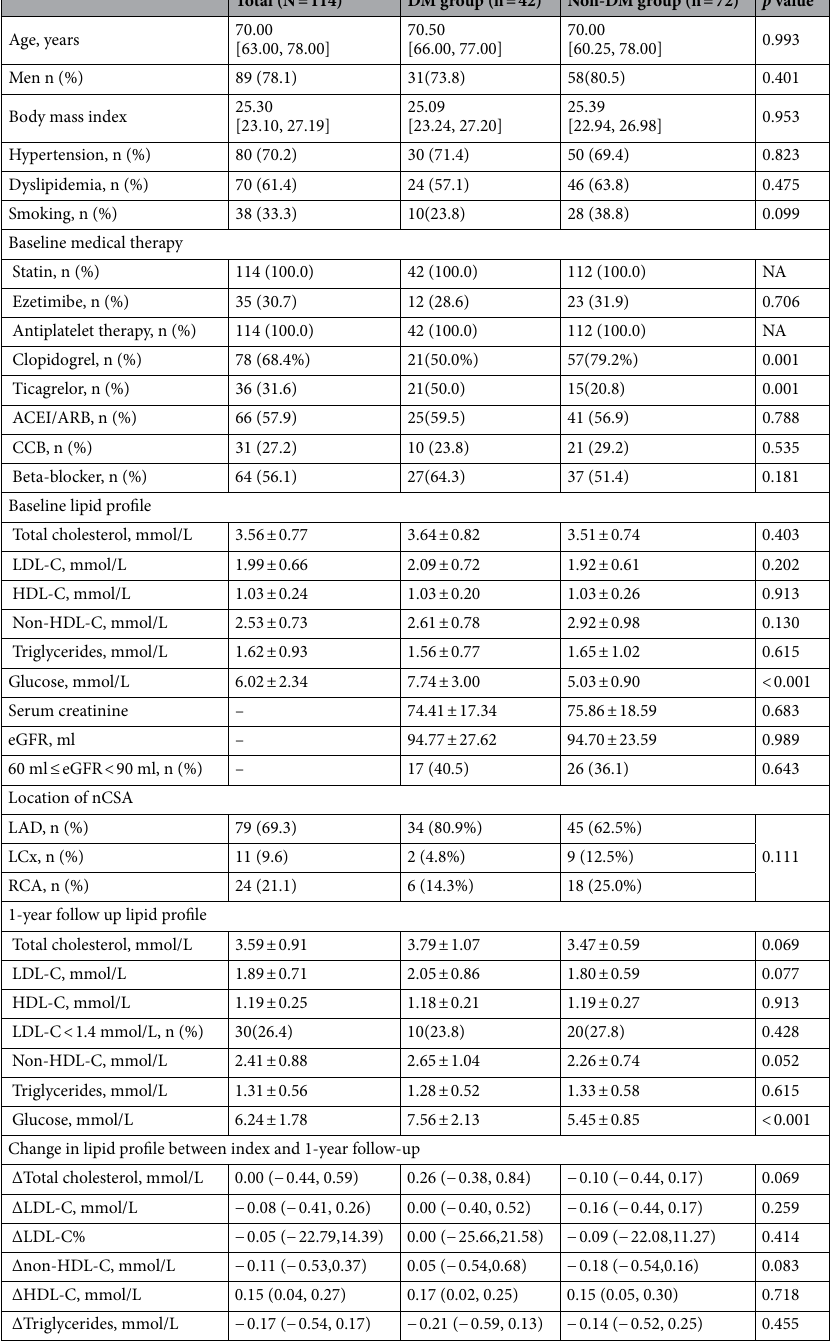
Table 2. Patient demographics in phase II analysis. Values are expressed as the median (interquartile range) for continuous variables with abnormal distribution and described as the mean ± standard deviation with normal distribution, or frequency (percentage) for categorical variables in the table. ACEI angiotensin- converting enzyme inhibitor, ARB angiotensin receptor blocker, CCB calcium channel blocker, DM diabetes mellitus, eGFR estimated glomerular filtration rate, HDL-C high-density lipoprotein cholesterol, LDL-C low- density lipoprotein